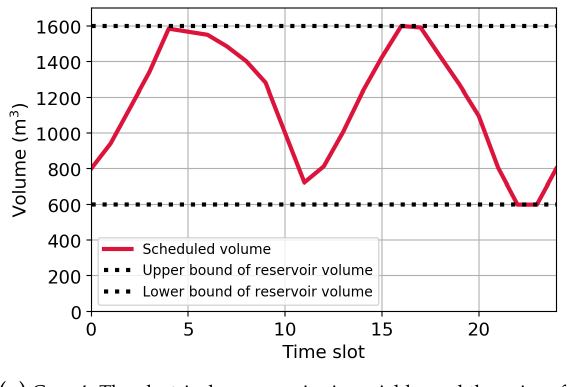
Figure 9. Results for the electrical load of water pumps under the variable electrical energy prices. The solid red, dashed blue, and dashed green lines indicate the planned power consumption of the water pump, when upward regulation reserve capacity provided to the power system is fully activated and when downward regulation reserve capacity provided to the power system is fully activated, respectively.